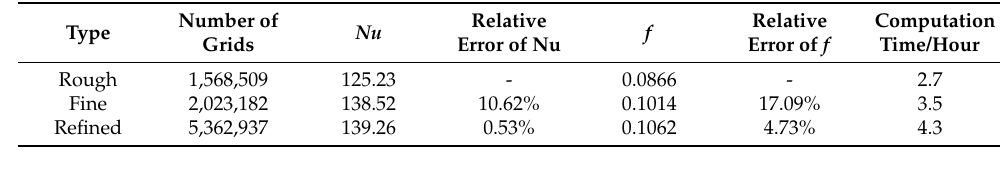
Table 3. Grid distribution type (for pipe 4#).